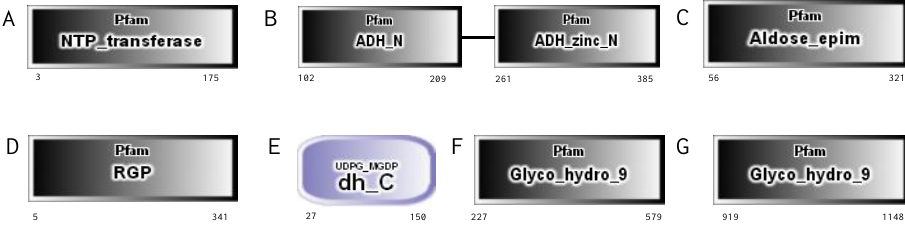
Figure 5. The functional domains of the putative cell wall genes. ( A ) The NTP transferase functional domain of MSTRG.46576; ( B ) The catalytic domain of alcohol dehydrogenases